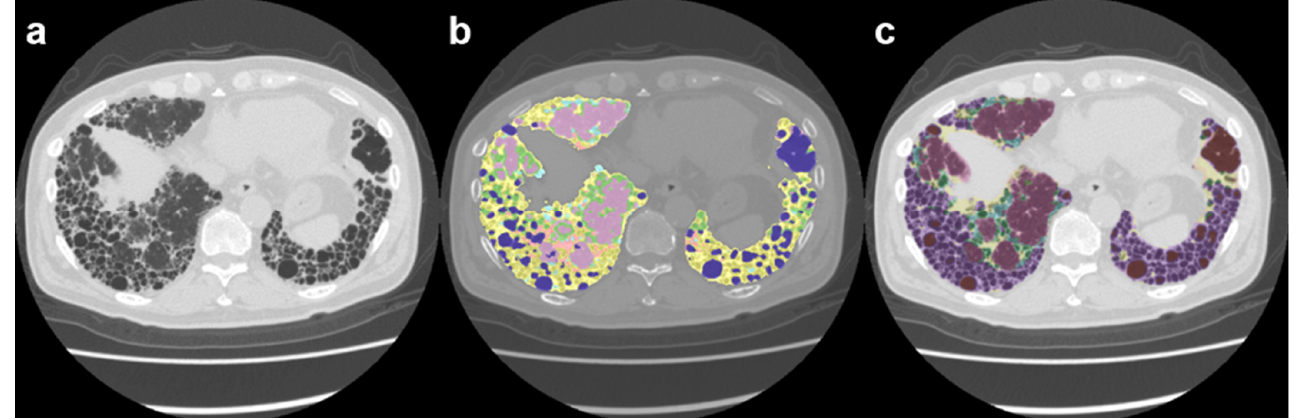
Figure 2. Images of a 72-year-old man with idiopathic pulmonary fibrosis (IPF). ( a ) Computed tomography image; ( b ) computer-aided diagnosis (CAD) method image; ( c ) deep-learning (DL)-based analysis image. Note: For the CAD image, purple = N CAD ; light green = G CAD ; pink = C CAD ; light blue = R CAD ; yellow = H CAD ; and dark blue = E CAD . For the DL-based analysis image, violet = N DL ; light green = G DL ; yellow = CF DL ; light blue = R DL ; dark green = T DL ; purple = H DL ; and brown = E DL . Table 2. Classification of the lung lesions according to the CAD and DL-based methods.